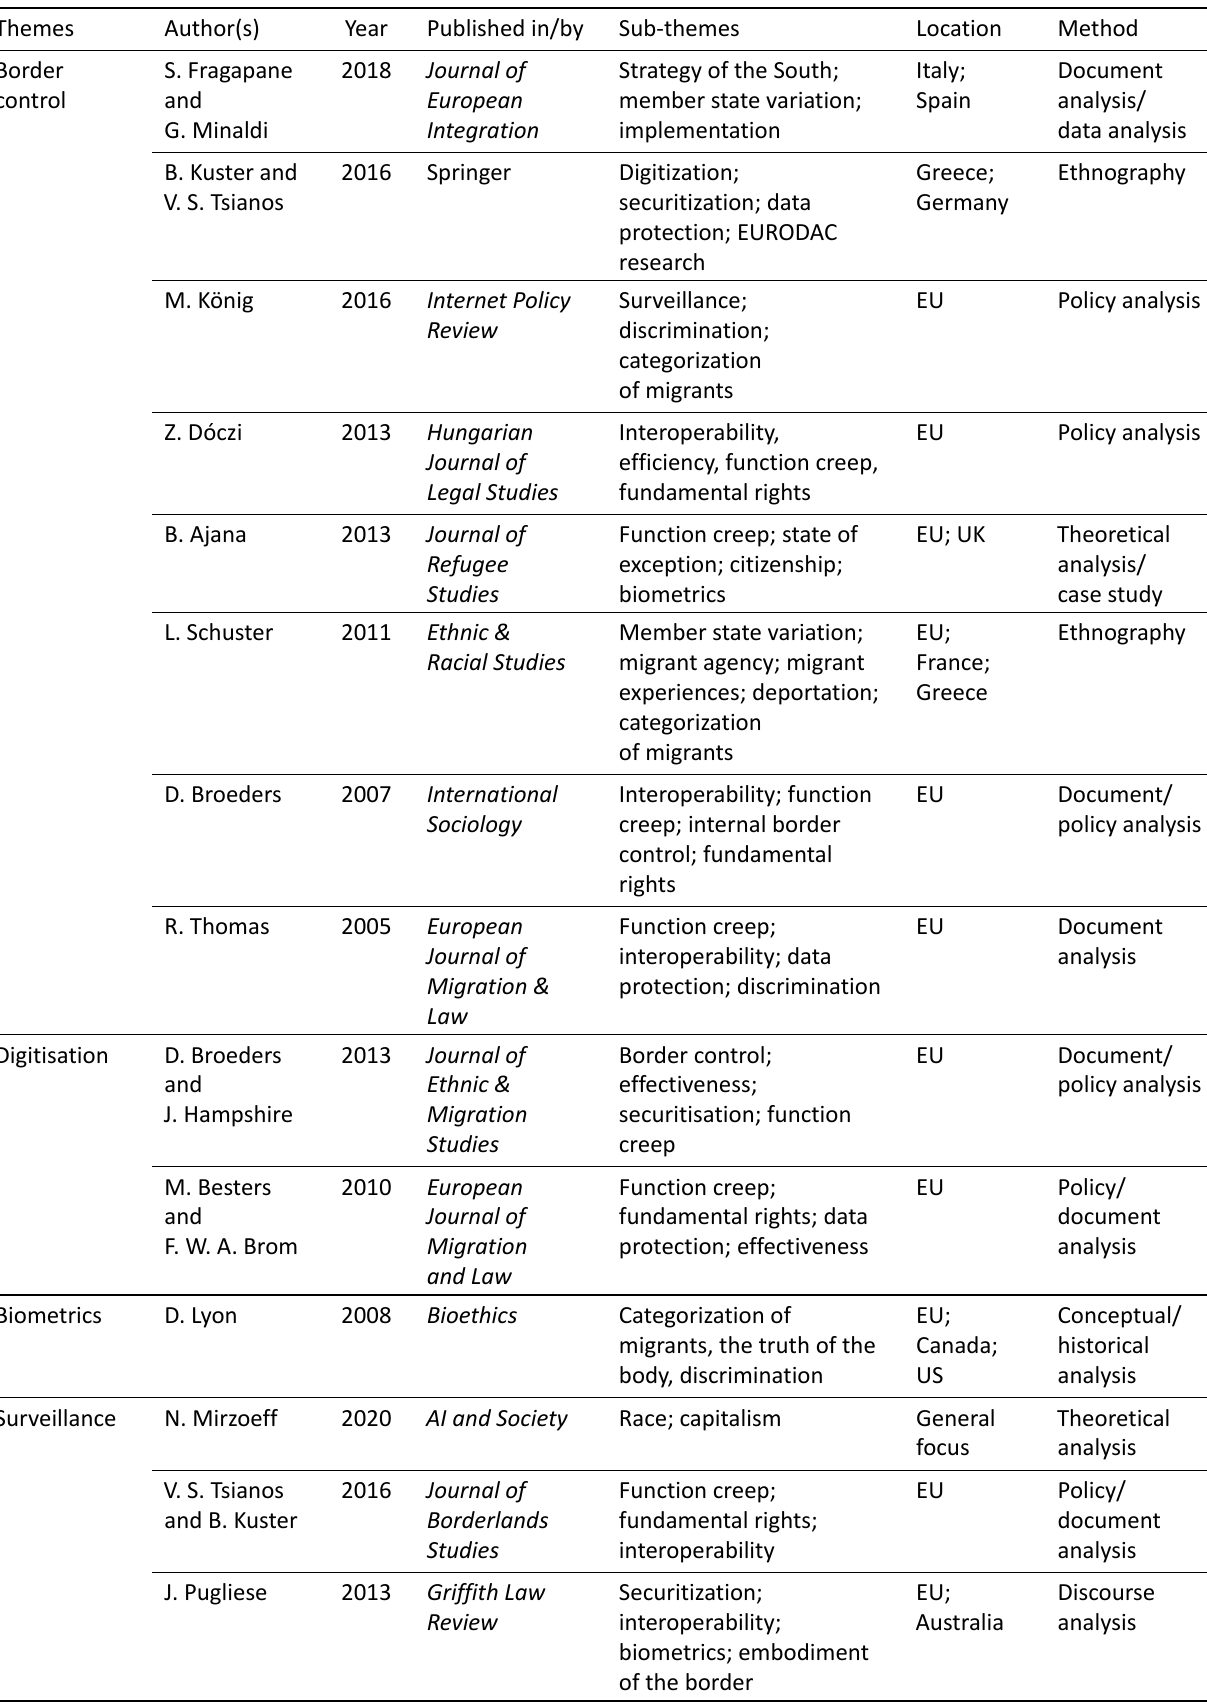
Table 1. Themes and key